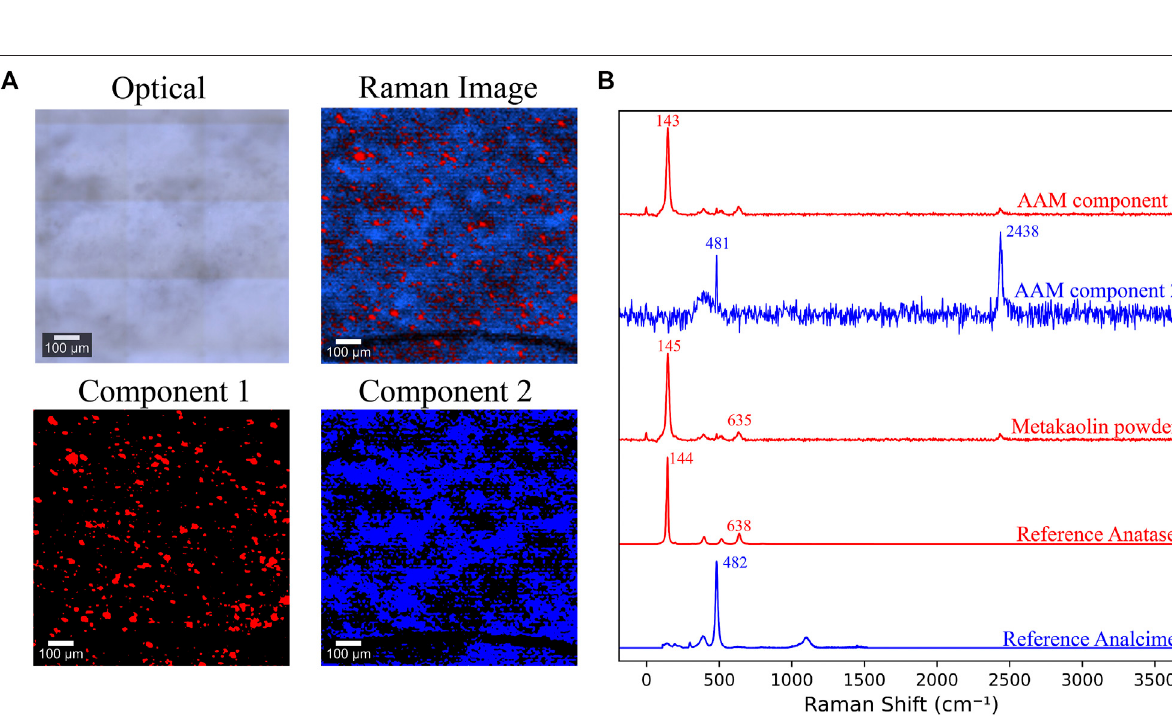
Frontiers in Chemistry |